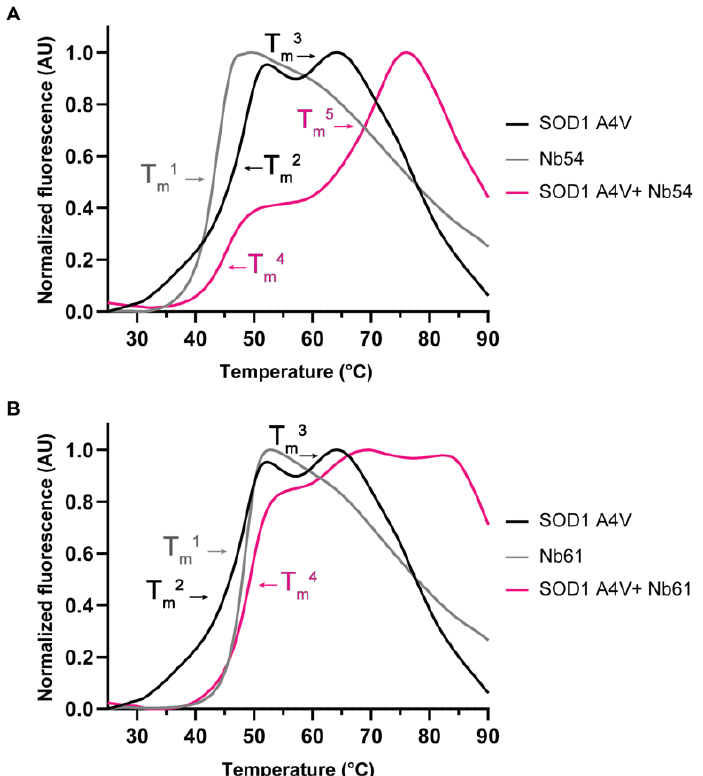
Figure 5. Binding of Nb54 and Nb61 confer stabilization to SOD1 A4V. Thermal denaturation profiles obtained by differential scanning fluorimetry (DSF) for SOD1 A4V and anti-SOD1 nanobodies alone and in complex. ( A ) SOD1 A4V (black curve), Nb54 (grey curve), and a mixture of SOD1 A4V and Nb54 (magenta curve). Addition of Nb54 to SOD1 A4V results in a higher-temperature (T m5 ) melting transition. T m1 = 43.8 °C, T m2 = 48.9 °C, T m3 = 60.0 °C, T m4 = 45.0 °C, T m5 = 71.1 °C. ( B ) As in ( A ) except with Nb61 (grey curve). Melting profile of Nb61/SOD1 A4V complex shows a peak at a higher temperature (~85 °C) compared to either SOD1 A4V or Nb61. T m 1 = 48.6 °C, T m 2 = 48.9 °C, T m 3 = 60.0 °C, T m4 = 49.5 °C. Data presented here are representative of n = 3 separate experiments.